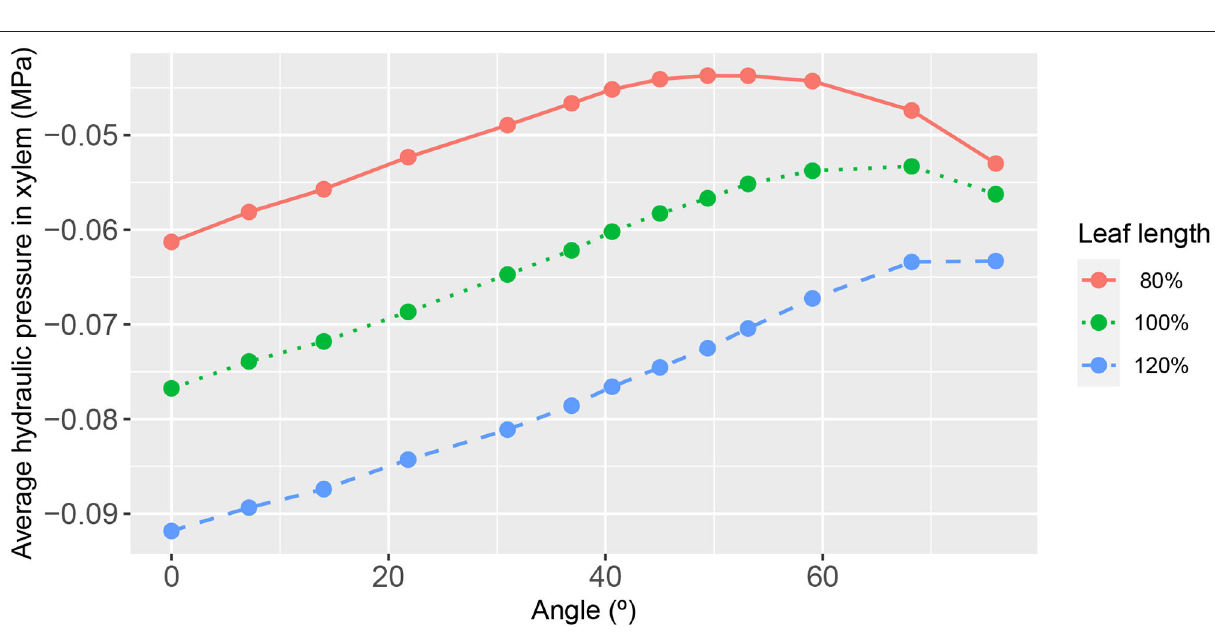
FIGURE 11 | The functional relationship between leaf area-average, xylem hydraulic pressure, and second-order vein angle. Curve descriptions and simulation conditions are as in Figure 7 except with a uniform second-order vein conductance of K xyl = 100 K ph / 3 = 2.5 × 10 − 3 mmol s − 1 m − 2 (i.e., an increase by a factor of 5 of the core